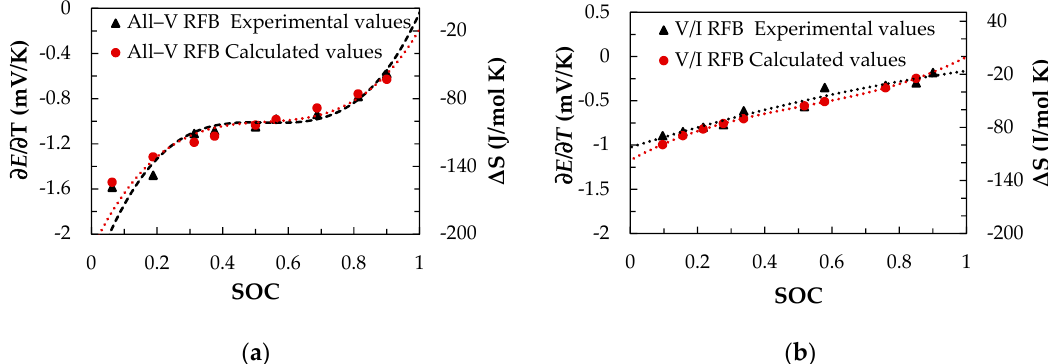
Figure 4. Measured ( ∂ E / ∂ T ) by monitoring of the ITI compared to calculate ∂ E / ∂ T as a function of the SOC for ( a ) an all-V RFB and ( b ) a V/I RFB.